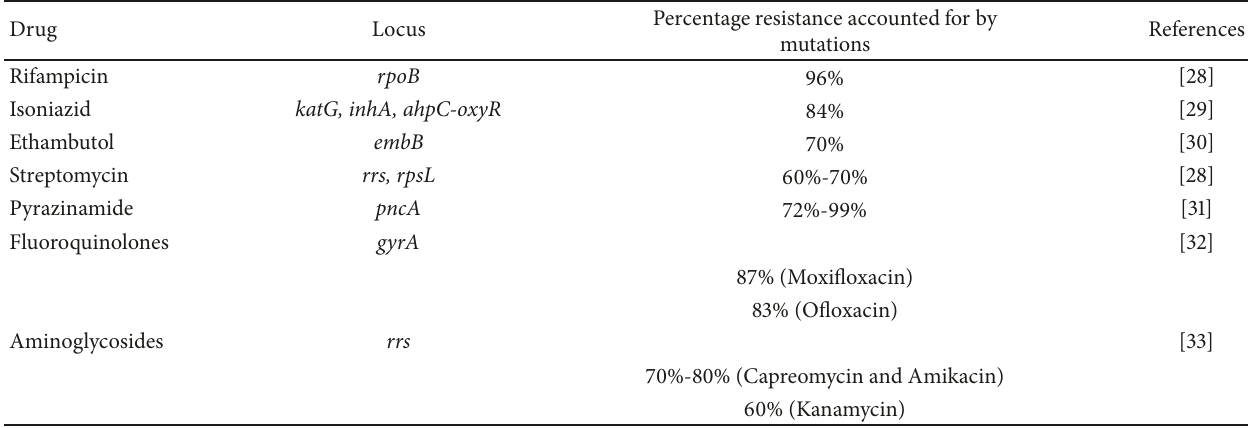
Table 3: Summary of the percentage phenotypic resistance that can be explained by genetic mutations at the locus of interest.